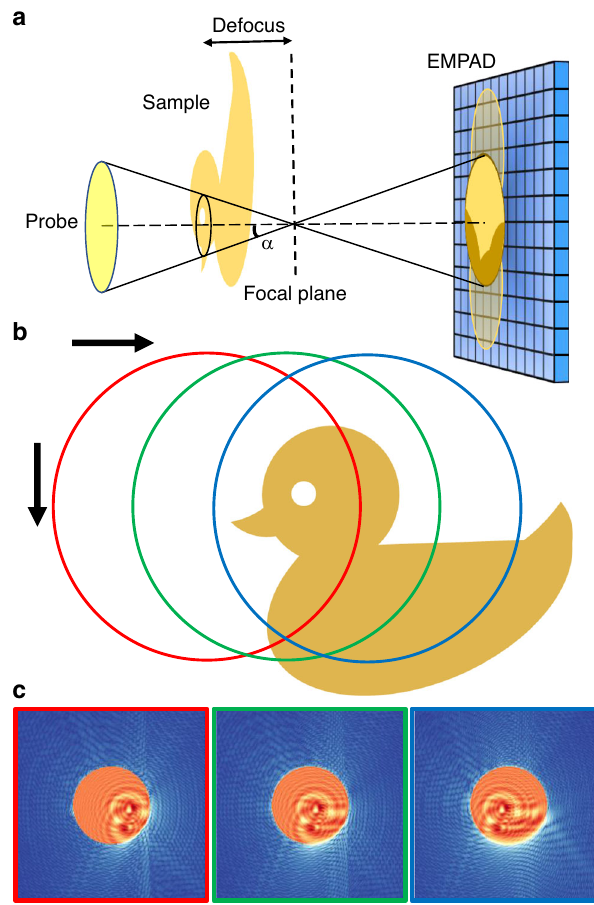
Fig. 1 Schematic of defocused probe electron ptychography. a Experimental setup. The focus of the electron probe is downstream from the sample at a distance de fi ned by the defocus value. The diffraction pattern on the detector (EMPAD) shows a shadow image in the bright- fi eld disk. b A diagram of the scan procedure. c Three diffraction patterns simulated when the probe is illuminated at the positions circled in b , which show the shadow images in the bright- fi eld disk shifting accordingly with the probe position. The speckles in the dark- fi eld region contain high frequency